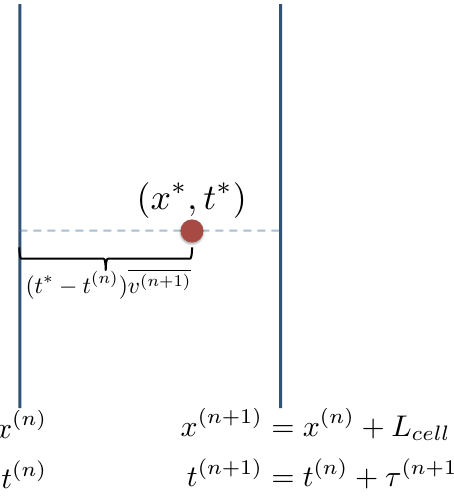
Figure 6. Illustration of the downscaling procedure in the x direction. A particle is in Cell n + 1 and will travel through that cell over an amount of time τ ( n + 1 ) . We want to determine the particle’s x location at time t ∗